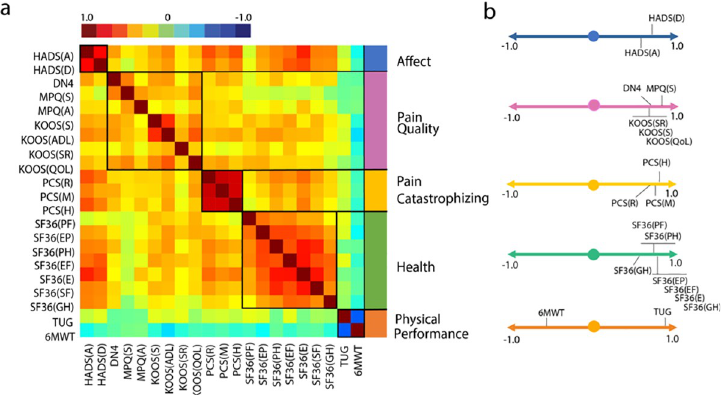
Fig 4. Principal component analysis identified five factors characterizing baseline KOA. Pain- and affect-related questionnaires, their subscales, and performance measures (prior to surgery) were examined together to identify dominant underlying factors. a. Correlation matrix ordered based on principal component analysis results (Pearson’s r represented by color bar). The five identified components were labeled according to membership properties. b. Factor loadings are shown for the five components. To highlight dominant factors threshold of factor loading was set on 0.5/- 0.5, after Promax oblique rotation. 6MWT, six minute walking test; DN4, The Neuropathic Pain 4 questions;